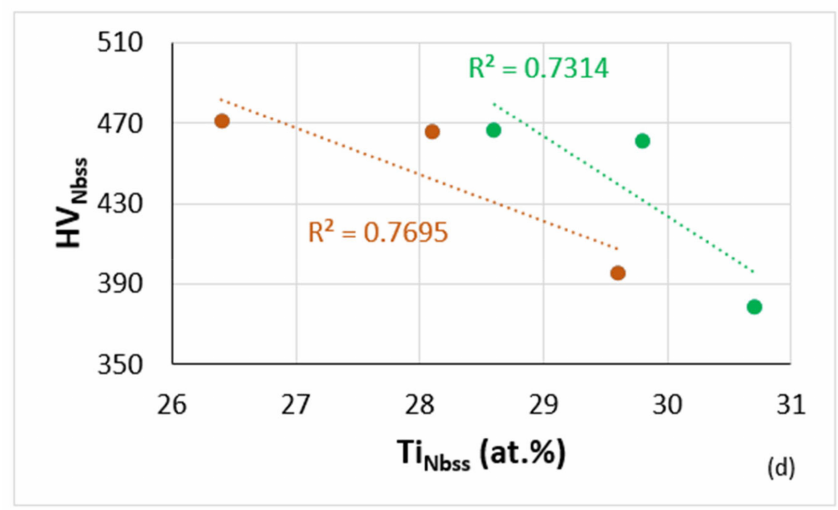
Figure 7. Vickers hardness (HV) of Nbss in the HT alloys TT2, TT3, TT4, TT8 versus ( a ) Ti + B + X, ( b ) Ti + X, (X = Al (blue), Cr (red)), ( c ) Ti/Cr for the alloys TT2, TT4, TT8, and ( d ) HV of Nbss in the HT alloys TT3, TT4, TT8 (green) and KZ7, KZ5 and JG3